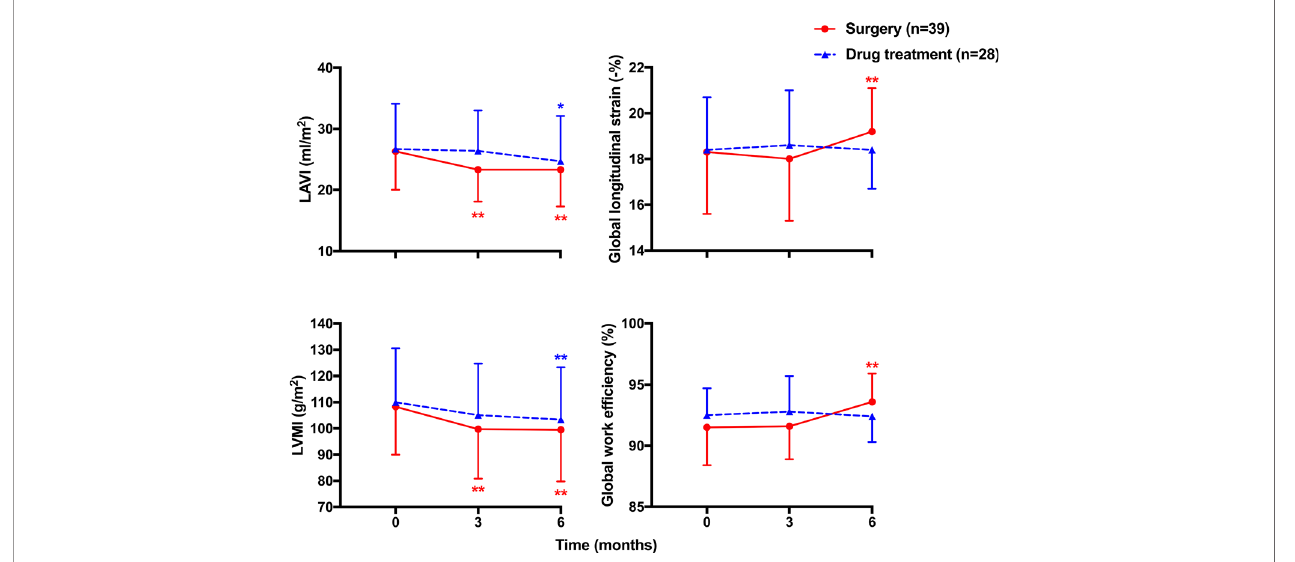
FIGURE 3 | Mean (± SD) values of cardiac structure (left panels) including left atrial volume index (LAVI) and left ventricular mass index (LVMI), and function (right panels) including global longitudinal strain and global work ef fi ciency of the left ventricle at baseline and during follow-up in patients treated with surgery (circles with solid line) and drugs (triangles with dashed line). * p < 0.05, ** p < 0.01 vs . baseline.